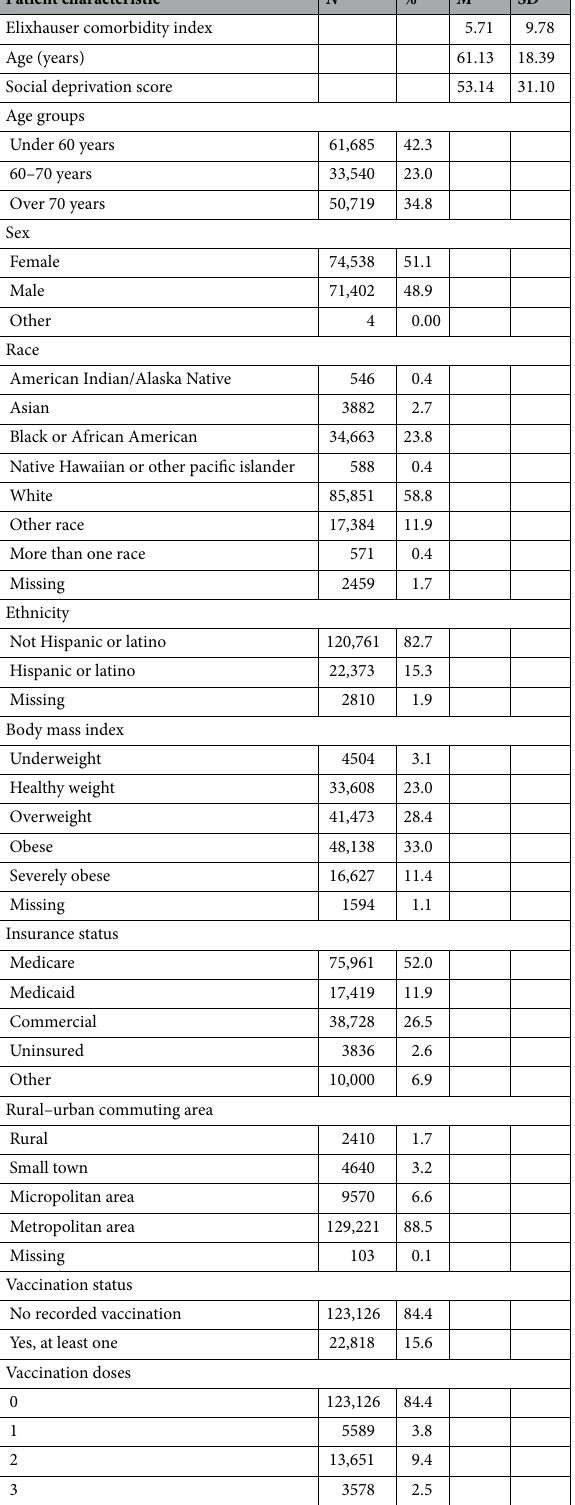
Table 1. The characteristics of the full sample averaged across patients from all health systems (N = 145,944) and including status on covariates and vaccination